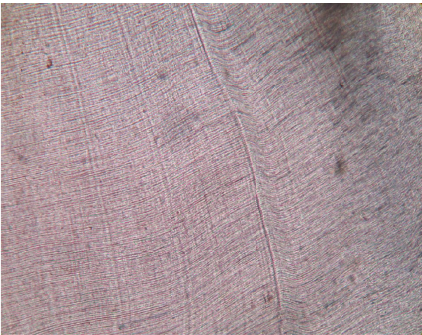
Figure 6: Dentinal tubules with incremental lines (photomicro- graph, ground section 10x).